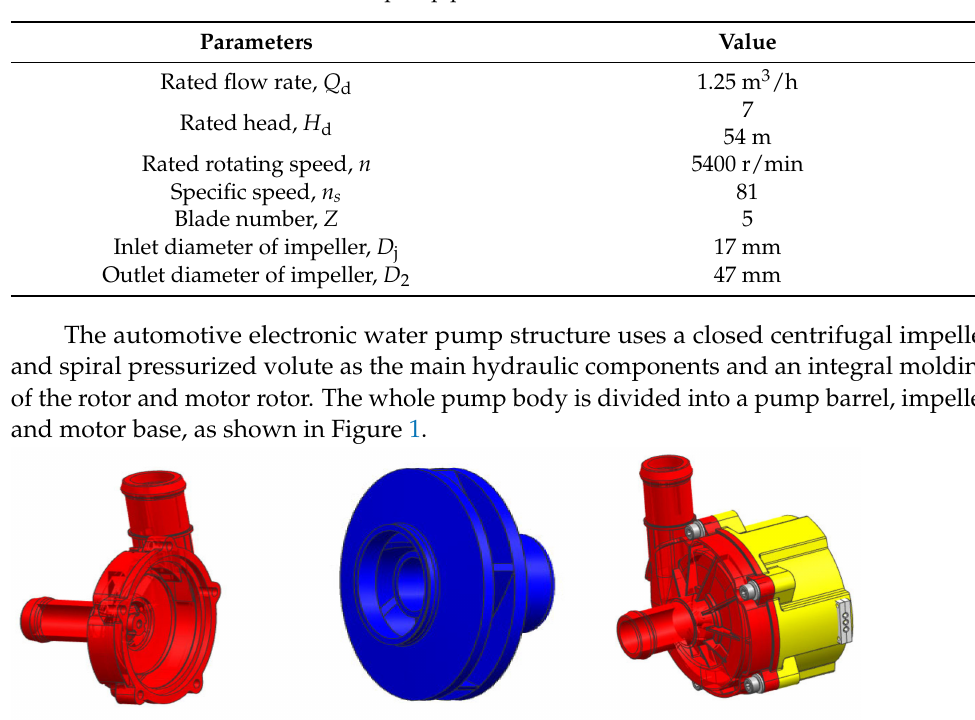
Table 1. Automotive electronic water pump parameters.